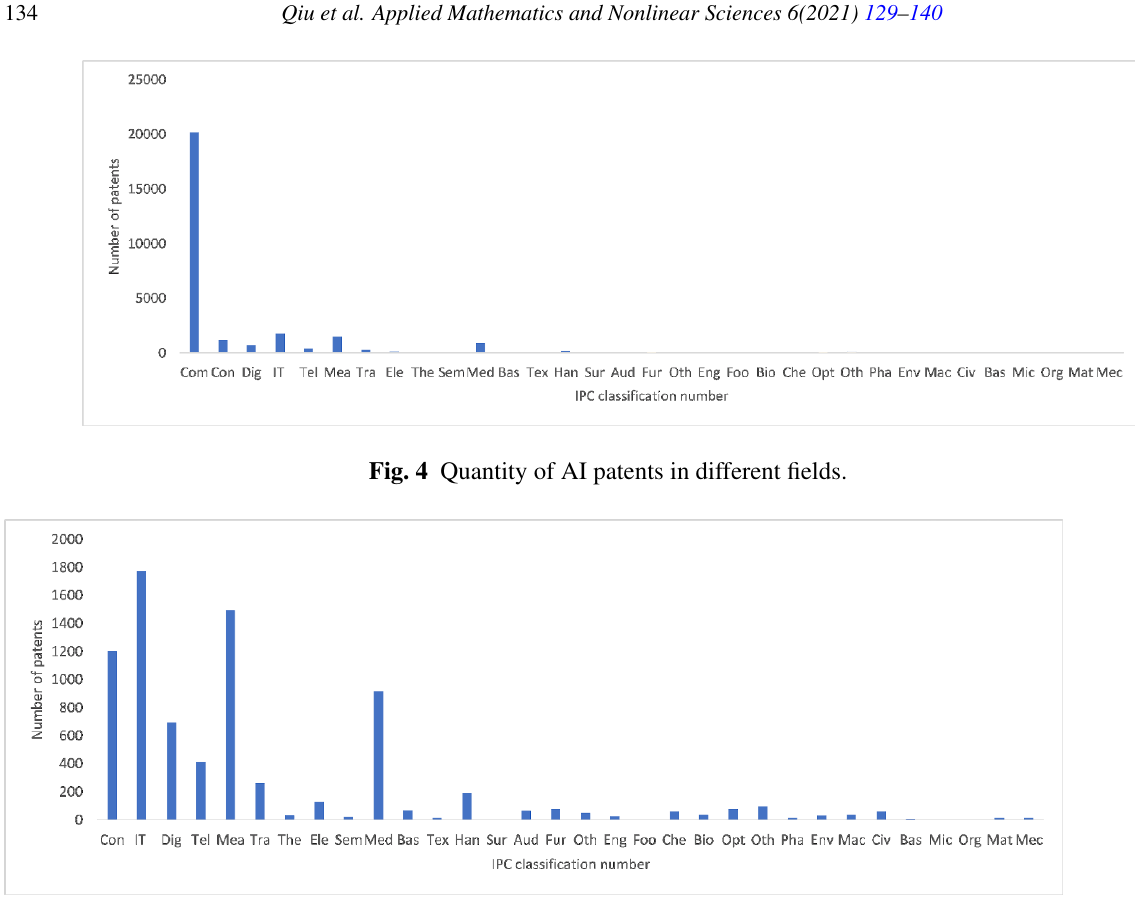
Fig. 5 Patent distribution after deleting the COM